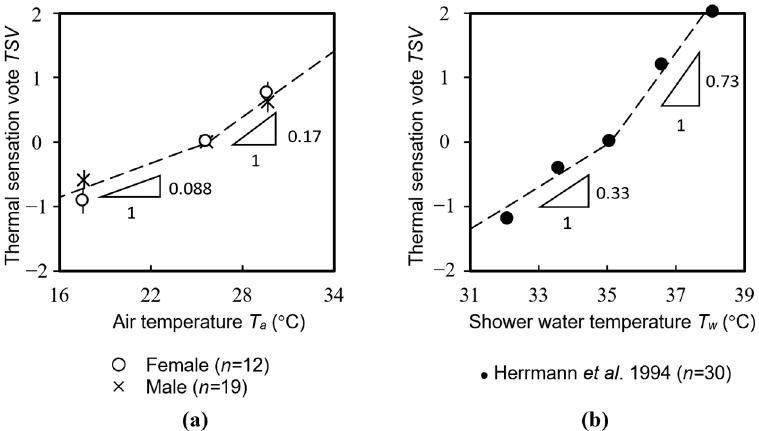
Figure 3. Subjective thermal responses to the showering environment: ( a ) thermal sensation votes of 12 females and 19 males at T w = 38.8 °C (SD = 0.7 °C) and at T a = 17.7, 25.8, 29.8 °C; ( b ) thermal sensation votes of 30 subjects at T w = 32.4, 33.9, 35.4, 36.9, 38.4 °C and at T a = 28 °C; the values reported by Herrmann et al. [9] are shown for comparison.